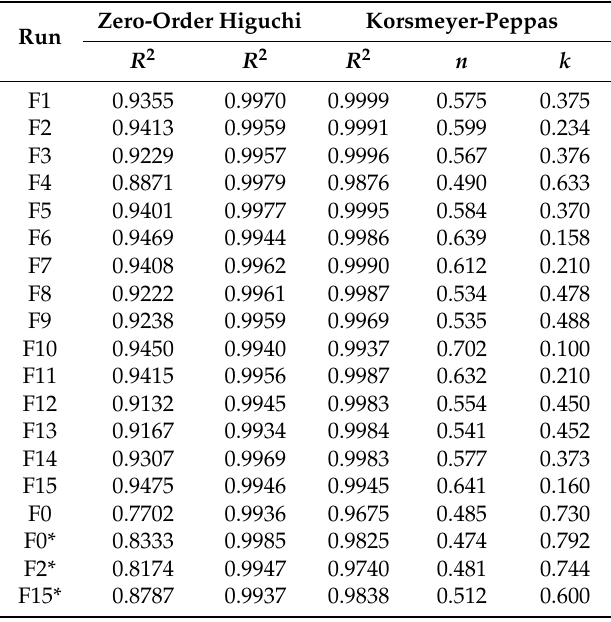
Figure 5. In vitro dissolution profiles of various formulations based on the BBD experimental design, ( a ) F1–8 and ( b ) F9–15. ( c ) Comparison of drug release profiles of tablets with sodium bicarbonate (F0, F2, and F15), and those without sodium bicarbonate (F0*, F2*, and F15*). Table 4. Correlation coefficient ( R 2 ) values for the dissolution profiles plugged into various release models.